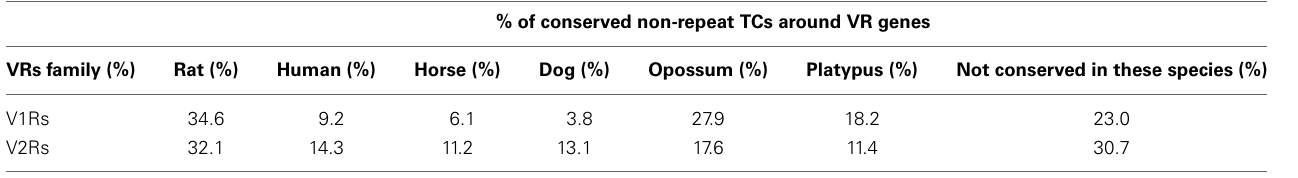
Table 3 | Percentages of non-repeat TCs overlapping with species-specific conserved blocks; a given TC can overlap with different species-specific blocks at the same time.